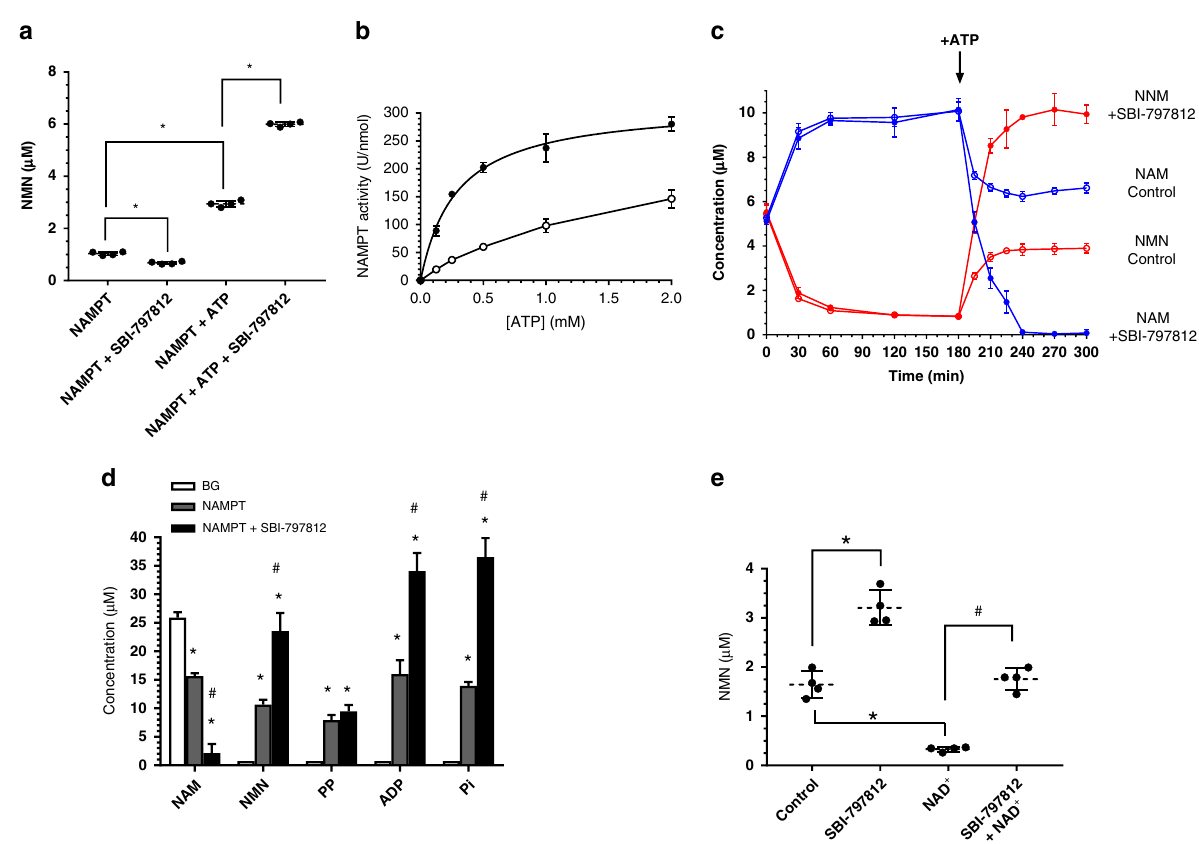
Fig. 2 SBI-797812 mechanism of action. a NAMPT activation by SBI-797812 requires ATP. NAMPT (30 nM) incubated with NAM (10 μ M) and PRPP (50 μ M) and, where indicated, ATP (2 mM) and/or SBI-797812 (2 μ M). Reactions performed at 37 °C for 1 or 4 h without or with ATP, respectively. NMN detected with the fl uorescence assay. Data normalized to NMN produced in 1 h. Data expressed as means ± s.d.; n = 4. * p < 0.001 compared to NAMPT or (NAMPT + ATP). One-way ANOVA with Tukey ’ s multiple comparisons test. b SBI-797812 increased NAMPT af fi nity for ATP. Without SBI-797812 (open circle), NAMPT (30 nM) incubated with NAM (10 μ M), PRPP (50 μ M), and varying ATP (0 – 2 mM). With 2 μ M SBI-797812 ( fi lled circle), reactions were identical except 15 nM NAMPT was used. Reactions performed for 1 h at 37 °C. NMN measured with the fl uorescence assay. Data normalized for NMN production in the absence of ATP and expressed as U nmol − 1 NAMPT; means ± s.d. are shown; n = 3. Curve fi tting using GraphPad Prism. c Impact of SBI- 797812 on NAMPT equilibrium reaction. NAMPT (200 nM) mixed with 5 μ M NAM, 100 μ M PRPP, 5 μ M NMN, 100 μ M PP with (closed) and without (open) SBI-797812 (1 μ M). Samples incubated at 37 °C and aliquots removed sequentially. At 3 h, 2 mM ATP was spiked. Incubation continued at 37 °C with aliquots sampled as indicated. NAM (blue) and NMN (red) assayed by LC-MS/MS. Data expressed as means± s.d.; n = 4. d Comprehensive pro fi ling of NAMPT reaction substrates/products. NAM (25 μ M), PRPP (50 μ M), and ATP (2 mM) incubated for 1 h at 37 °C in buffer without (BG) or with NAMPT (100 nM). Where indicated, SBI-797812 (5 μ M) was included. Samples assayed for NAM, NMN and ADP by LC-MS/MS. Pi and PP determined by colorimetric assay. Data expressed as means ± s.d.; n = 6 except for BG (NAM, NMN, and ADP assays), n = 5. * P < 0.0001, vs. BG in each group; # p < 0.0001, NAMPT vs. (NAMPT + SBI-797812) in each group. 1-way ANOVA with Tukey ’ s multiple comparisons test. e SBI-797812 blunted NAD + -mediated feedback inhibition of NAMPT activity. NAMPT (30 nM) incubated with NAM (10 μ M), PRPP (50 μ M), ATP (2 mM) for 1 h at 37 °C. SBI-797812 (2 μ M) or NAD + (250 μ M) included as indicated. NMN measured by LC-MS/MS. Data expressed as means ± s.d.; n = 4. * p < 0.0001 vs. Control; # p < 0.0001 vs. NAD + . 1-way ANOVA with Tukey ’ s multiple comparisons test. For Fig. 2a – e, source data are provided as a Source Data fi